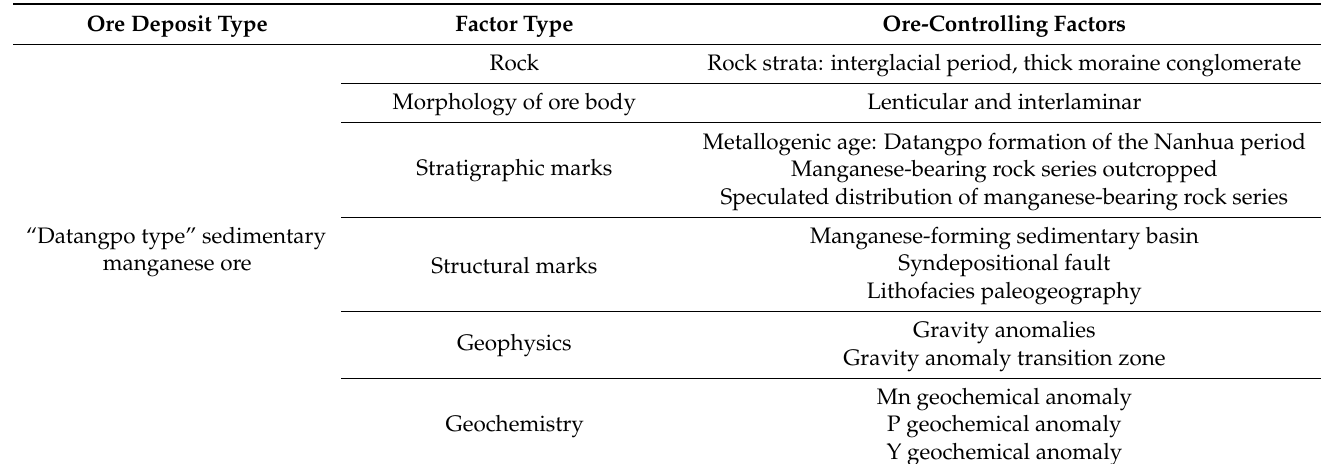
Table 1. The conceptual prediction model of Songtao-Huayuan manganese deposits. Ore Deposit